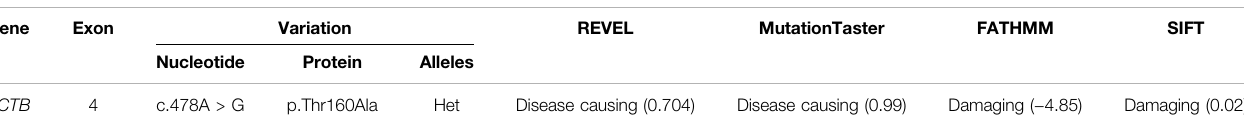
TABLE 2 | Characteristics of ACTB variant and analysis of disease-causing